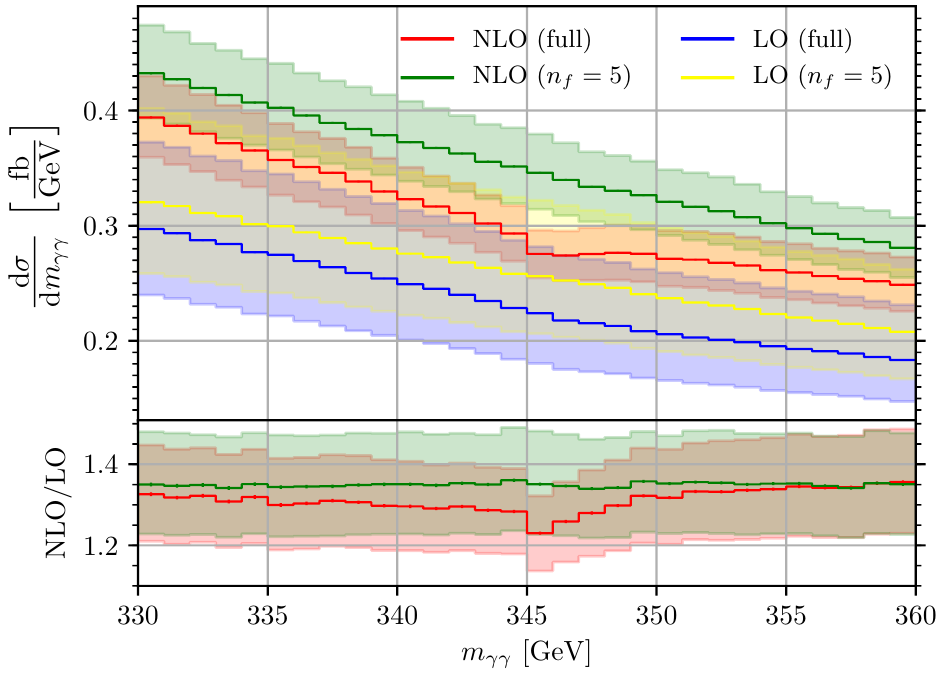
Figure 4. Zoom into the threshold region of the diphoton invariant mass distribution ((cid:12)xed order calculation), showing the n f = 5 and full result separately. The shaded bands indicate the scale uncertainties, while the bars indicate uncertainties due to the numerical evaluation of the phase- space and loop integrals. The ratio plot in the lower panel shows the ratios NLO(full) = LO(full) (red) and NLO( n f = 5) = LO( n f = 5) (green), with the scale variation bands obtained by varying the scale in the numerators